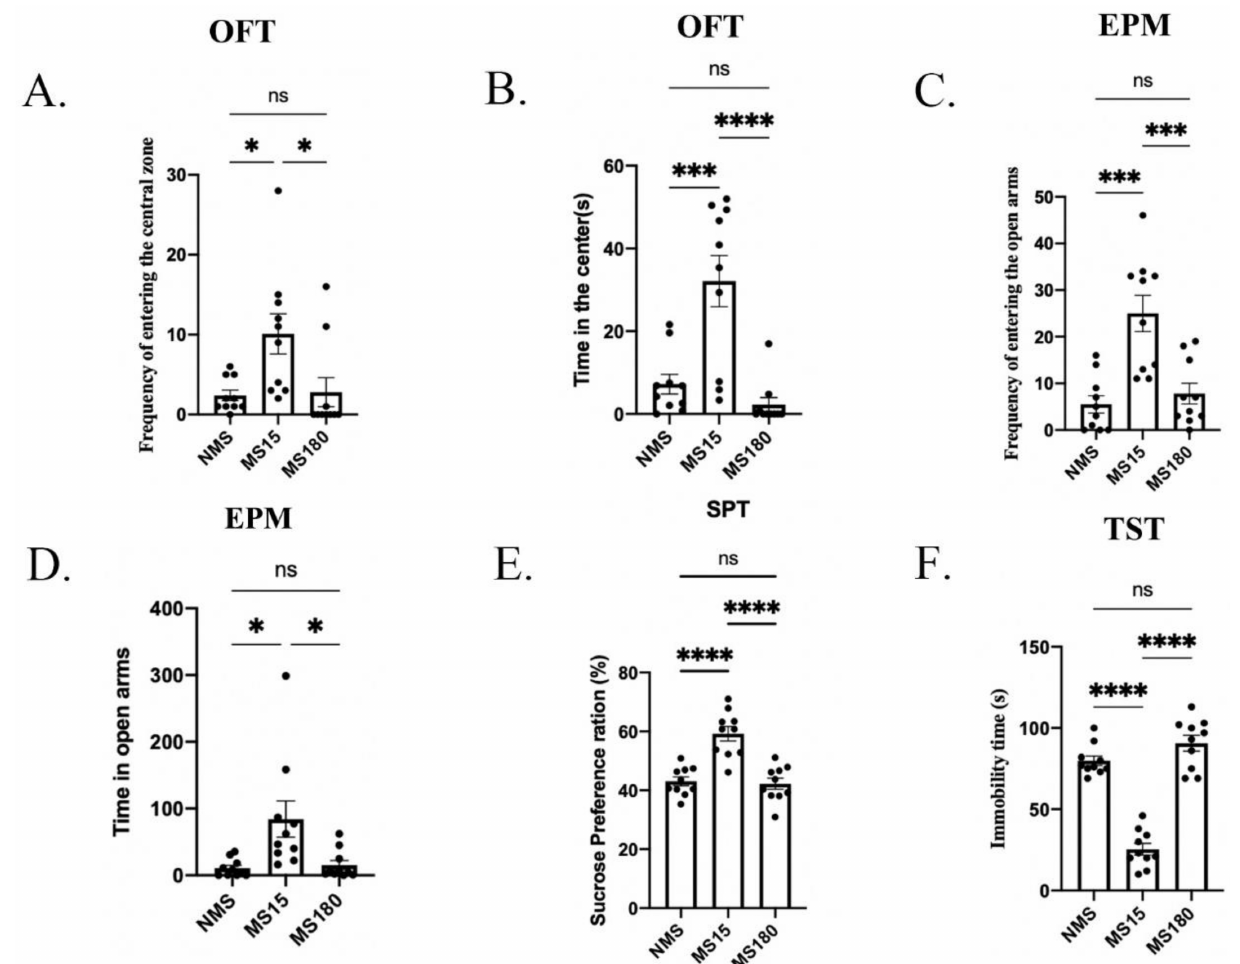
Figure 6. Brief PS during lactation conferred stress resilience to behavioral deficits in IMQ-induced psoriasis-like female mice. ( A ) The frequencies of entering the center; ( B ) time in the center in the OFT. ( C ) The frequencies of entering the center; ( D ) time in open arms in the EPM. ( E ) The sucrose preference ratio in the SPT. ( F ) Immobility time in the TST. Each value represents the mean ± SEM. n = 10 animals per group. Three groups were analyzed using ANOVA followed by a post hoc analysis (ns p > 0.05, * p < 0.05, *** p < 0.001 and **** p <